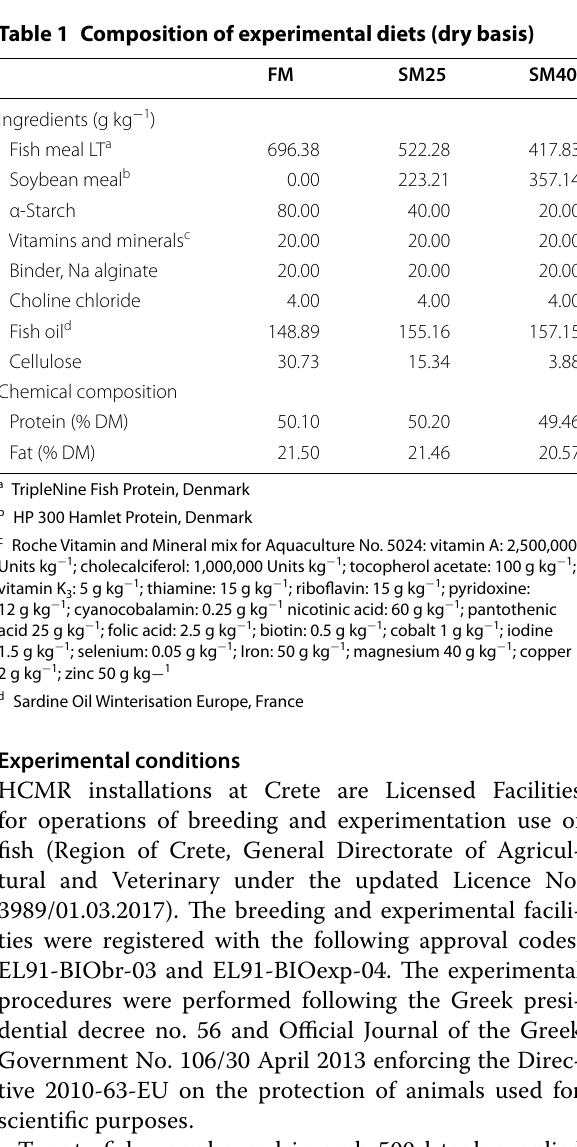
Table 1 Composition of experimental diets (dry basis)